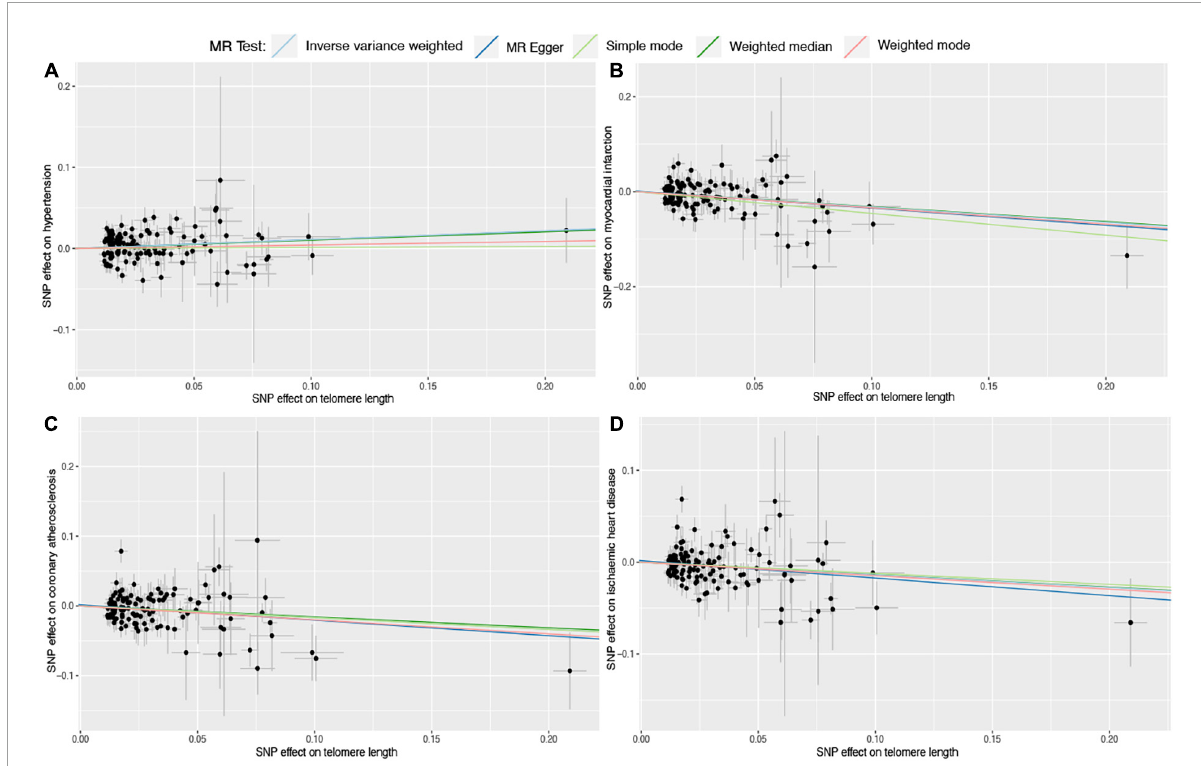
FIGURE3 Scatter plots for Mendelian randomization (MR) analyses of the correlation between telomere length (TL) and cardiovascular diseases (CVDs). (A) TL-hypertension; (B) TL-myocardial infarction; (C) TL-coronary atherosclerosis; (D) TL-ischemic heart disease. The slope of each line corresponds to the estimated association effect between TL and the risk of CVDs of different MR